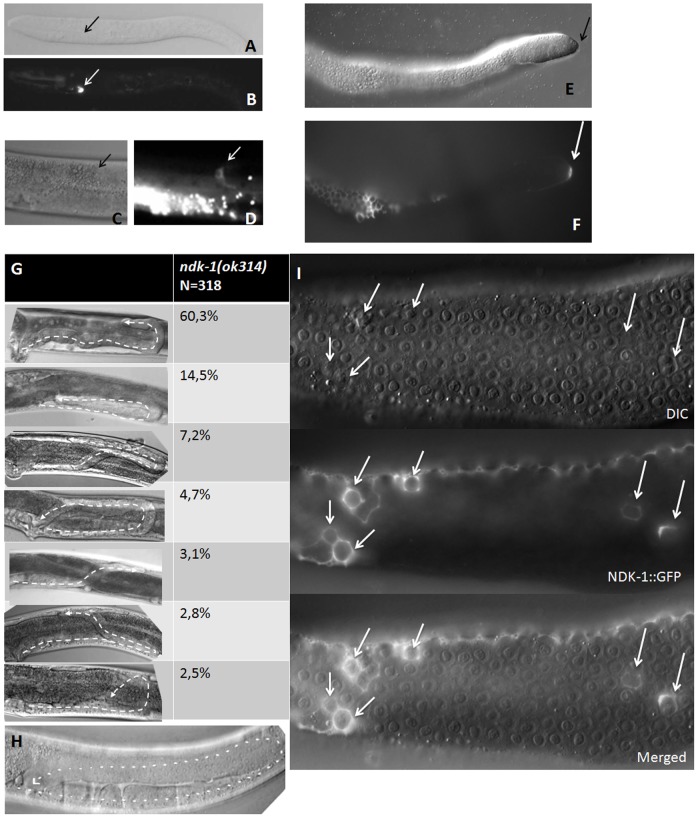
NDK-1 functions in DTCs.NDK-1::GFP shows expression in distal tip cells (DTCs) in TTV2 (B, D) and TTV3 (F) translational reporter lines in L3 (A, B), L4 (C, D) larvae and adults (E, F and I). A, C, and E are the corresponding DIC images of B, D, and F, respectively. DTC locations are indicated with arrows. We note that on panel D GFP expression in DTC (marked by an arrow) is overshadowed by intense expression of autofluorescent granules in the intestine. E, F and I: gonads were isolated from adult animals. H: DIC image of an adult wild-type (N2) gonad arm. G: Variation and distribution of DTC migration phenotypes observed in ndk-1(ok314) mutants (see details in the main text). The migratory path of DTCs is marked by dashed lines. I: In TTV3 lines carrying the integrated transgene, NDK-1::GFP expression is also observed in gonadal sheath cells. DIC, fluorescent and merged images derive from the gonadal loop region of a transgenic animal. On the DIC panel white arrows show dying cells, which are surrounded by sheath cells strongly expressing NDK-1::GFP (white arrows on the fluorescent and merged panels).